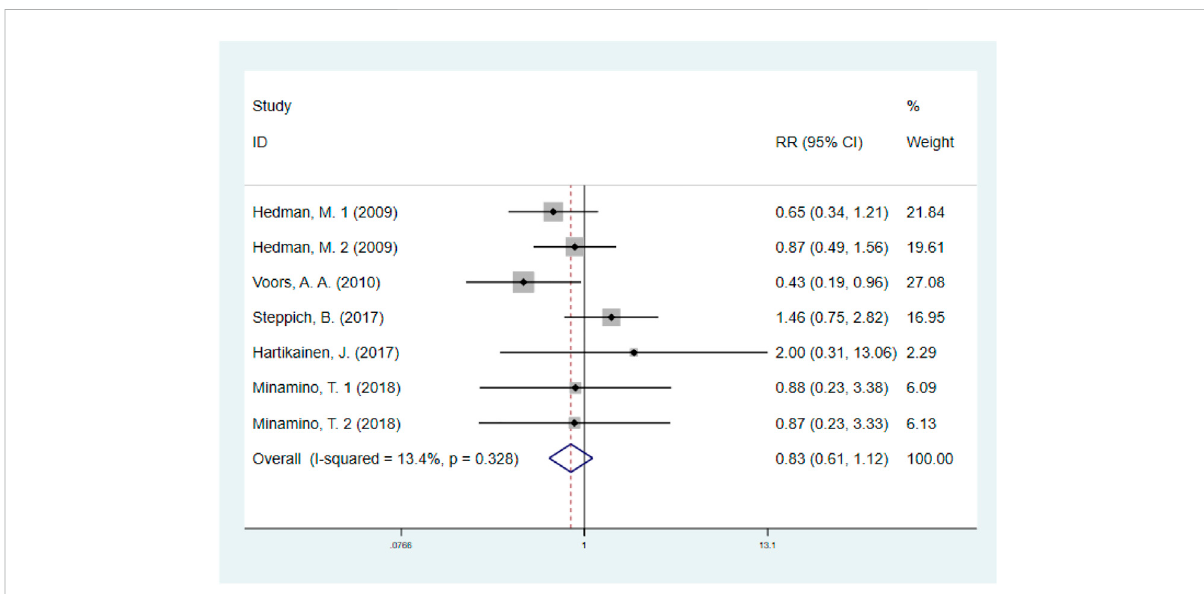
FIGURE 4 Forest plot for MACE, GF vs. control. MACE, major adverse cardiovascular events; RR, relative risk; CI, con fi dence interval; ID, identi fi cation.